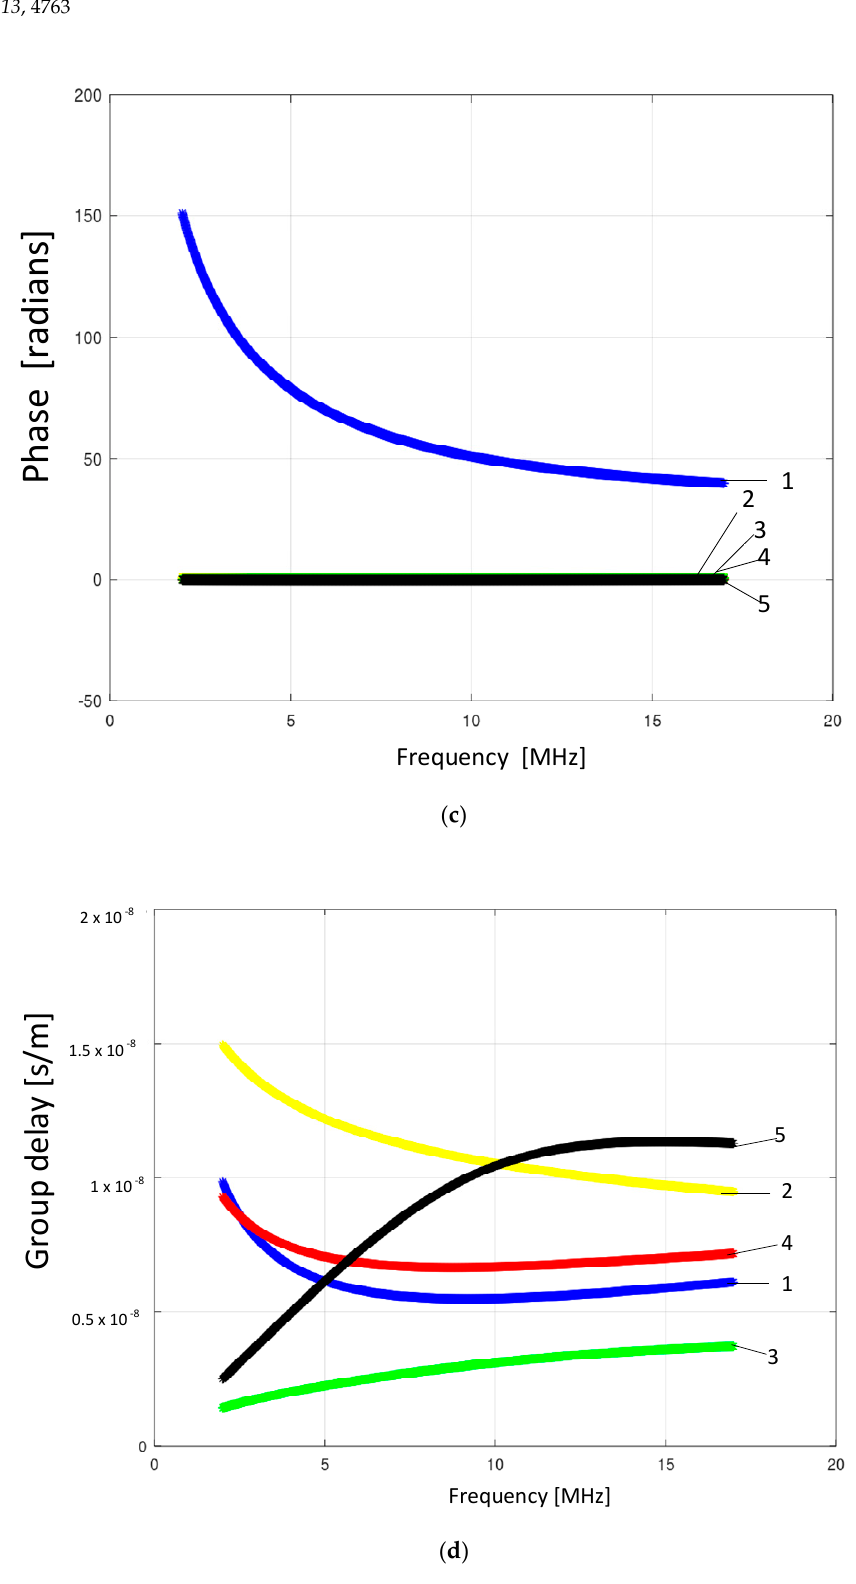
Figure 4. The impact of the cable’s electrical parameters and frequency for the inductive-inductive coupling: ( a ) Comparison of measured and derived values of attenuation factor α as a function of cable length (1–5—analyzed approaches, 6–measurement results, 7–regression line); ( b ) Calculated characteristic impedance Z 0 of the analyzed cable as a function of frequency in 5 analyzed approaches; ( c ) Calculated phase value as a function of frequency in 5 analyzed approaches; ( d ) Calculated group delay versus frequency in 5 analyzed